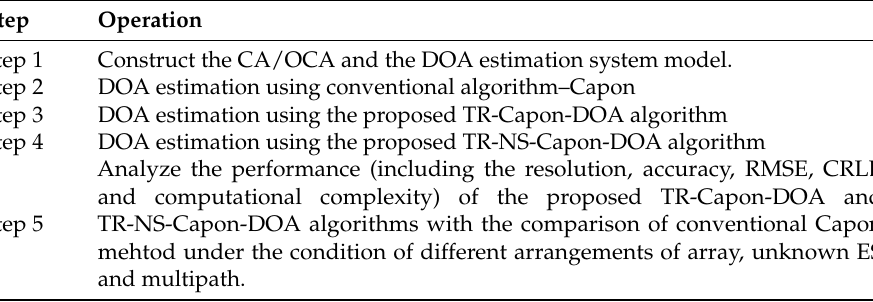
Table 3. Summarized steps of the proposed